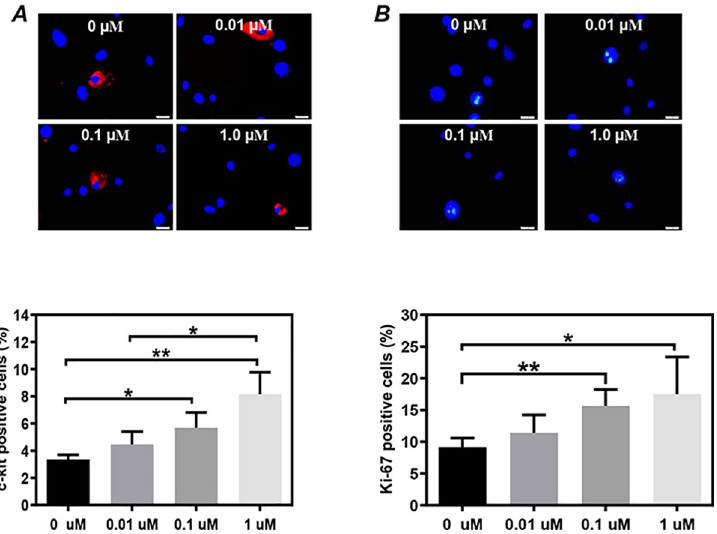
Fig 3. Dose dependency of the 17 β -estradiol supplement on the expression of c-kit and Ki67 in cardiac stem cells (CSCs) from healthy female mice. The expression of c-kit (A) and Ki-67 (B) in CSCs from healthy female mice were evaluated by immunostaining after 3 days of culture with the supplement of different concentrations of 17 β -estradiol in the medium. Representative images (upper) and Quantitative data (lower) . The nuclei were labeled with DAPI. Scale bar: 20 μ m. Control: sham-operated mice, Ovx: ovariectomized mice, LE 2 : ovariectomized mice received a low dose of 17 β -estradiol (0.01 mg/60 days), HE 2 : ovariectomized mice received a high dose of 17 β -estradiol (0.18 mg/60 days). All data are mean ± SD from 3 independent experiments (n = 3 for each group). � P < 0.05, �� P < 0.01.